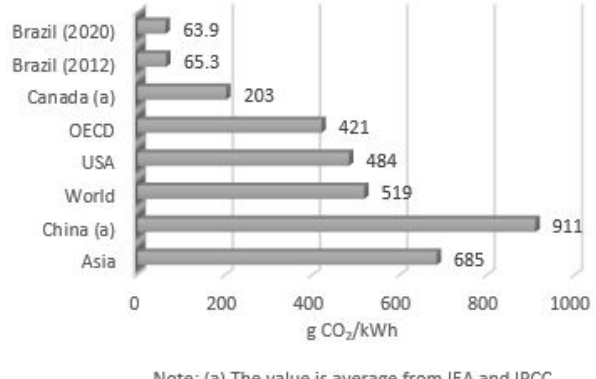
Figure 3. Electricity emission factor. Data were sourced from References [12,14].